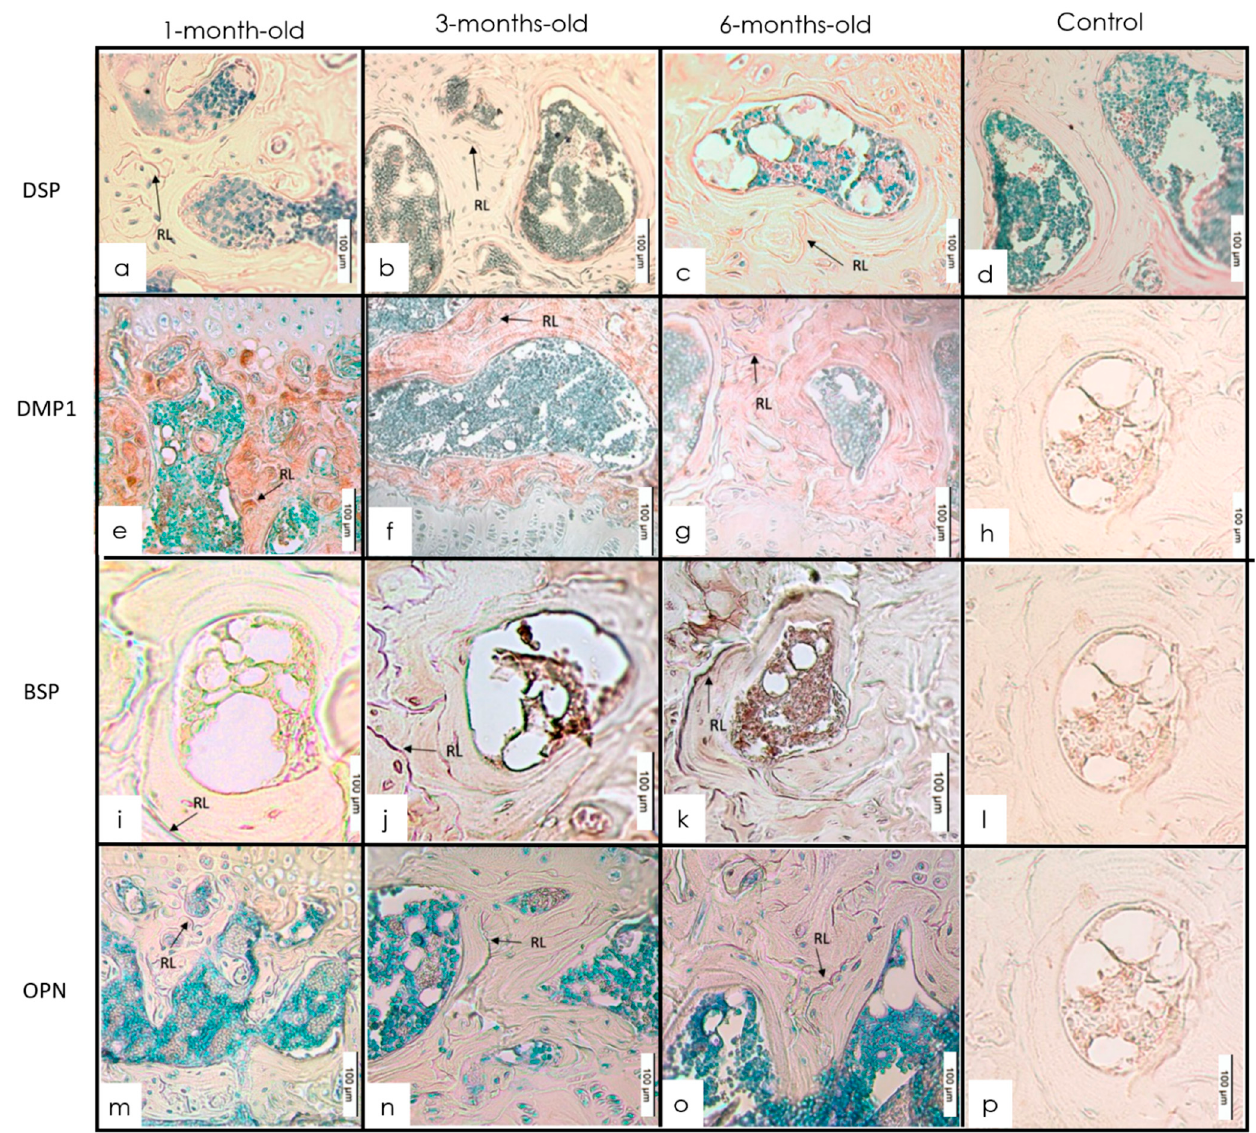
Figure 2. ( a – d ) Expression of staining intensity of DSP at 1, 3, and 6 months in the epiphysis